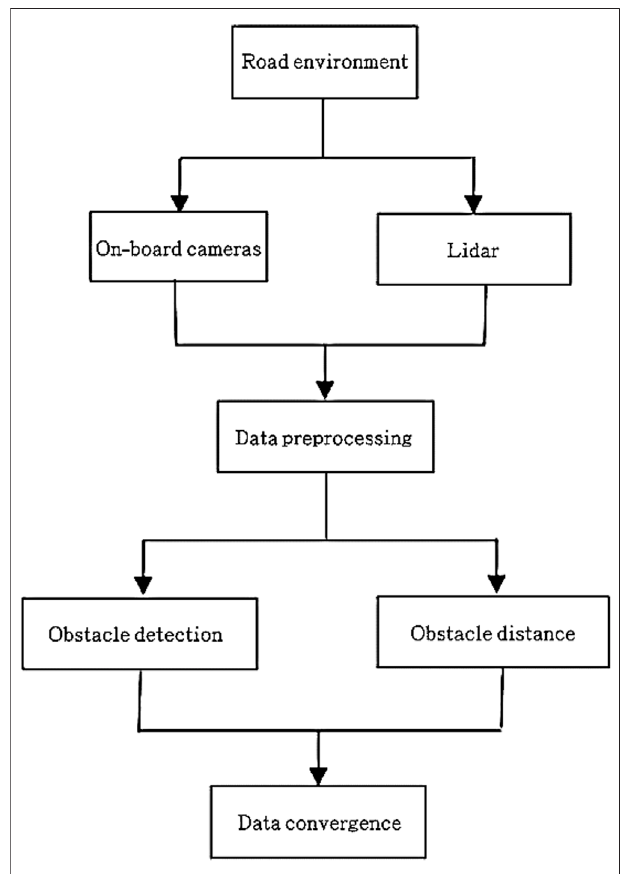
FIGURE 1 | Data convergence